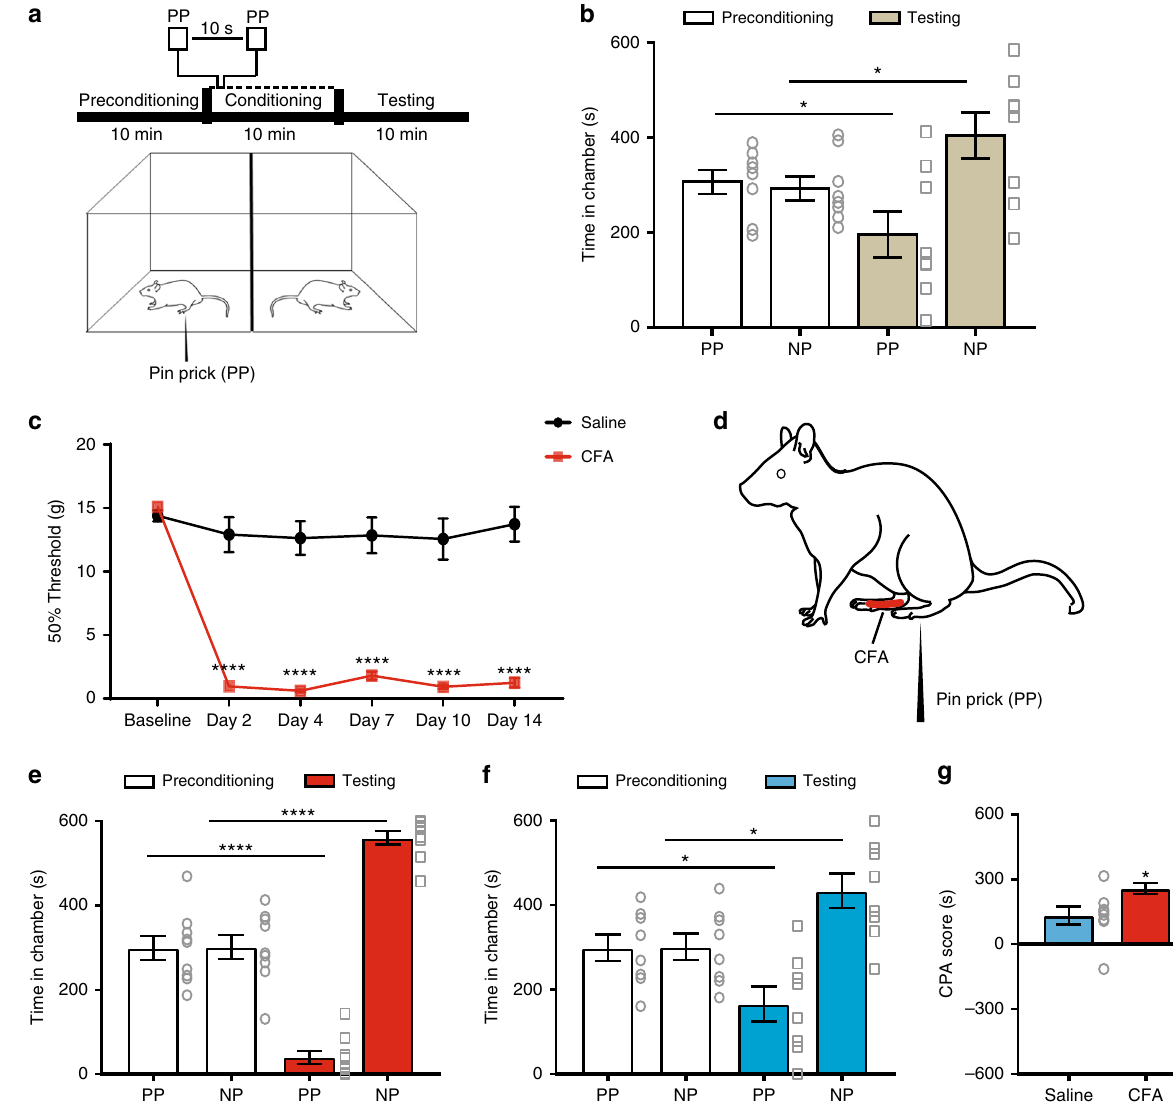
Fig. 1 Chronic pain increases the aversive response to noxious peripheral stimulations. a We evaluated the aversive response to noxious stimulations in rats with a two-chamber conditioned place aversion (CPA) test. During the conditioning phase, one chamber was paired with pin prick (PP), while the other chamber was not paired with painful stimulation (NP). b Naive rats displayed avoidance of the chamber associated with acute pain (PP); n = 8; p = 0.0259, paired Student ’ s t- test. c CFA injection induced mechanical allodynia in the injured paw, n = 6; p < 0.0001. Two-way ANOVA with repeated measures